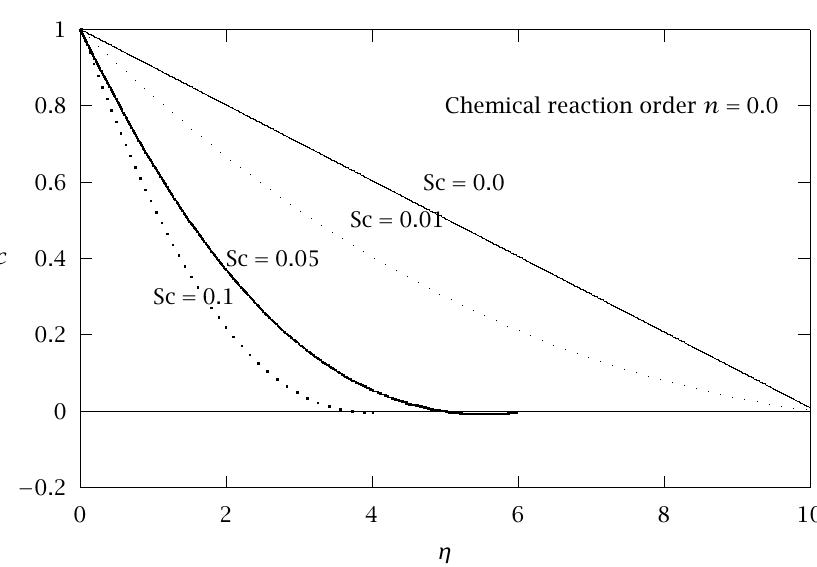
Figure 5.3 . Zeroth order concentration